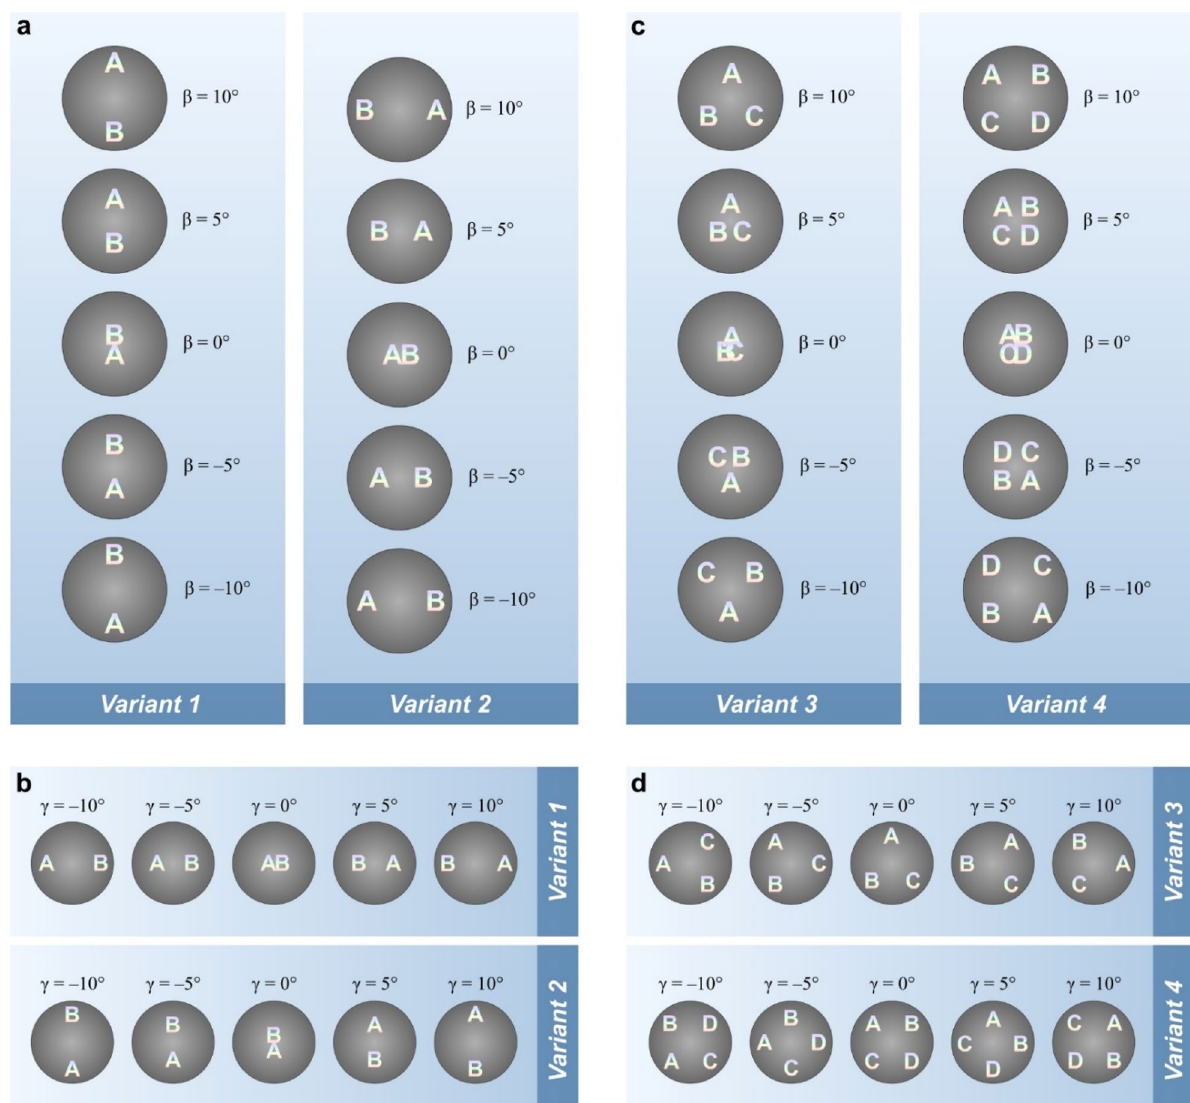
Figure 3. Kinematic effects of the motion of symbols in DOEs made according to variants 1–4. ( a ), Variants 1 and 2 in the case where the image is tilted up/down. ( b ) Variants 1 and 2 in the case where the image is tilted left/right. ( c ) Variants 3 and 4 in the case where the image is tilted up/down. ( b ) Variants 3 and 4 in the case where the image is tilted